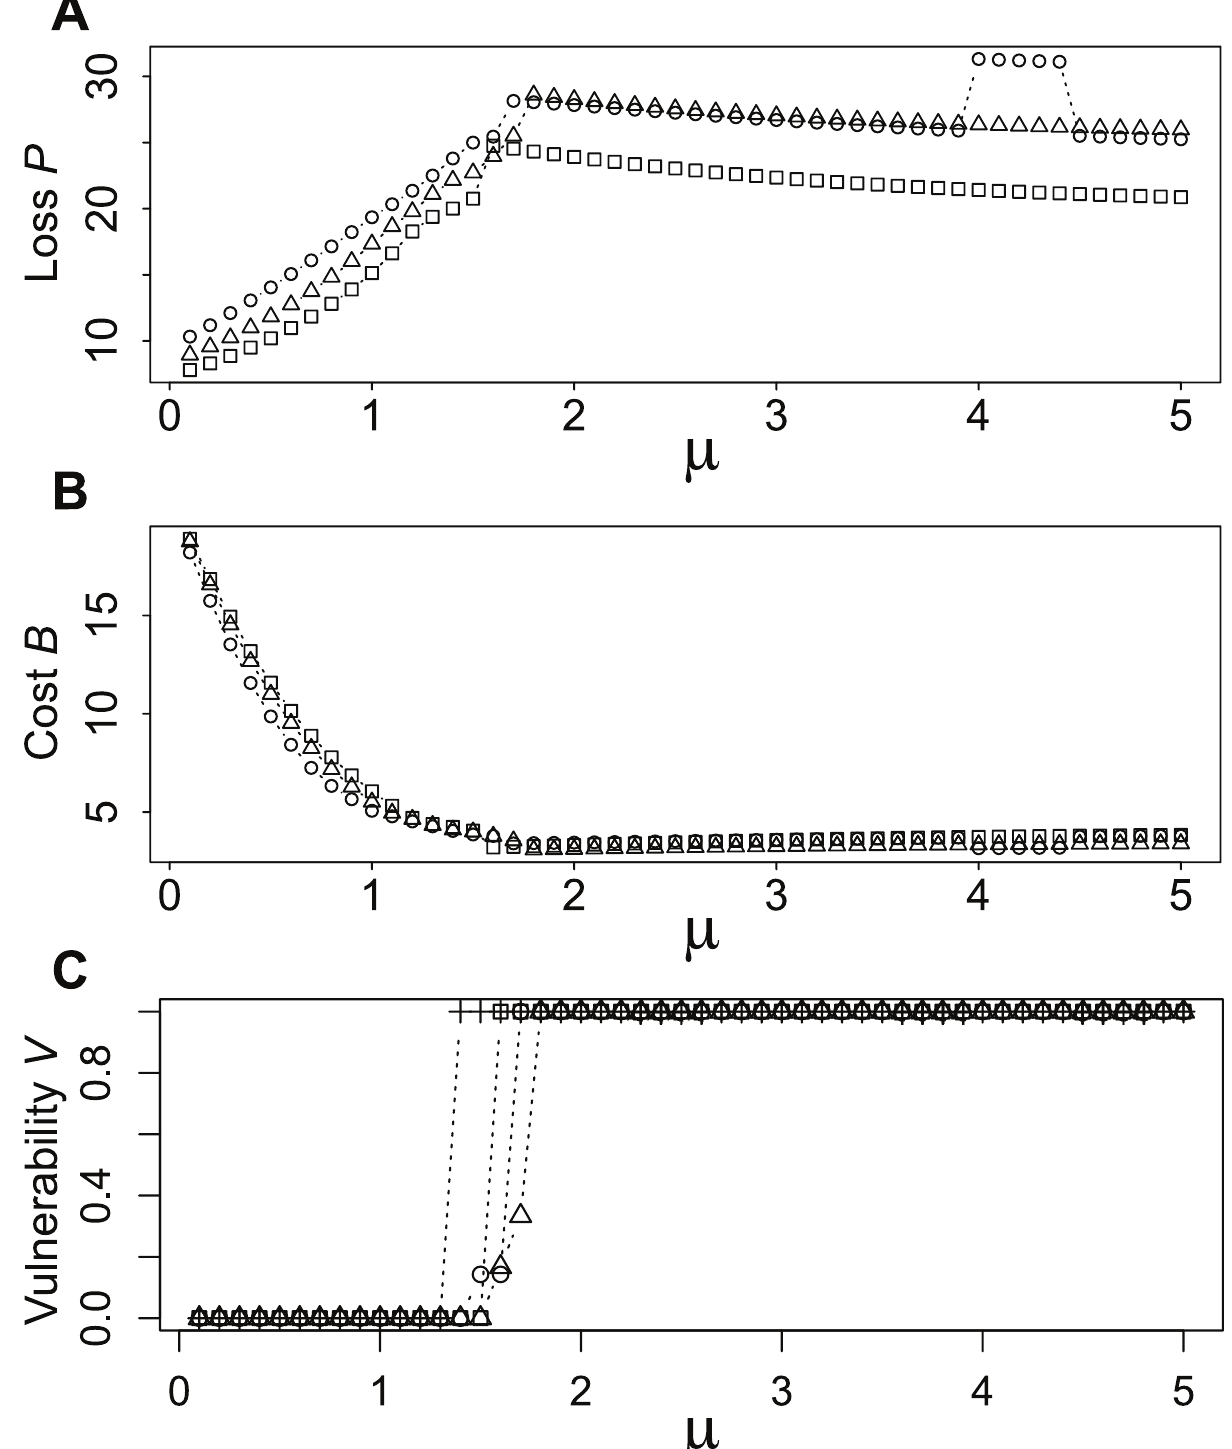
Figure 5. Performance depending on parameters m and . A Loss P . B Cost B . C Vulnerability V . Circles, triangles and squares denote performances when ~ 0, p = 2, p , respectively. The crosses in C denote the performances of the constant condition. The data are those for the homogeneous initial conditions of D ij . The case starting from non-homogeneous initial conditions is demonstrated in } 3 in File S1.